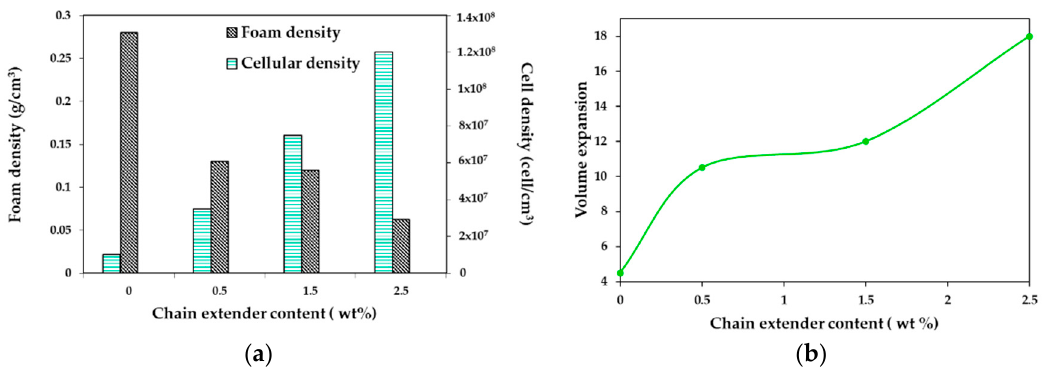
Figure 15. Foam characterization of PLA/wood flour composite foams: ( a ) Foam density and cell density, and ( b ) expansion ratio as a function of CE content. Data taken from Wang et al. [130].